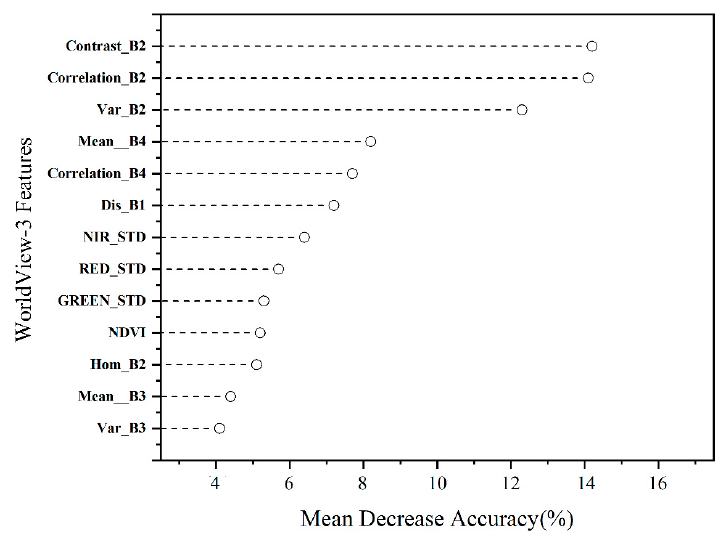
Figure 6. The MDA ranking of feature variables from Worldview-3 data. Note: Contrast_B2, Correlation_B2, and Var_B2 are the contrast, correlation, and variance of the green band of GLCM, respectively; Mean_B4 and Correlation_B4 are the mean and correlation of the near-infrared band GLCM; Dis_B1 is the dissimilarity of the red band of GLCM; NIR_STD is the variance in the near-infrared band; RED_STD is the variance in the red band; GREEN_STD is the variance in the green band; Hom_B2 is the homogeneity of the green band of GLCM; Mean_B3 is the mean of the blue band of GLCM; Var_B3 is the variance of the blue band of GLCM.